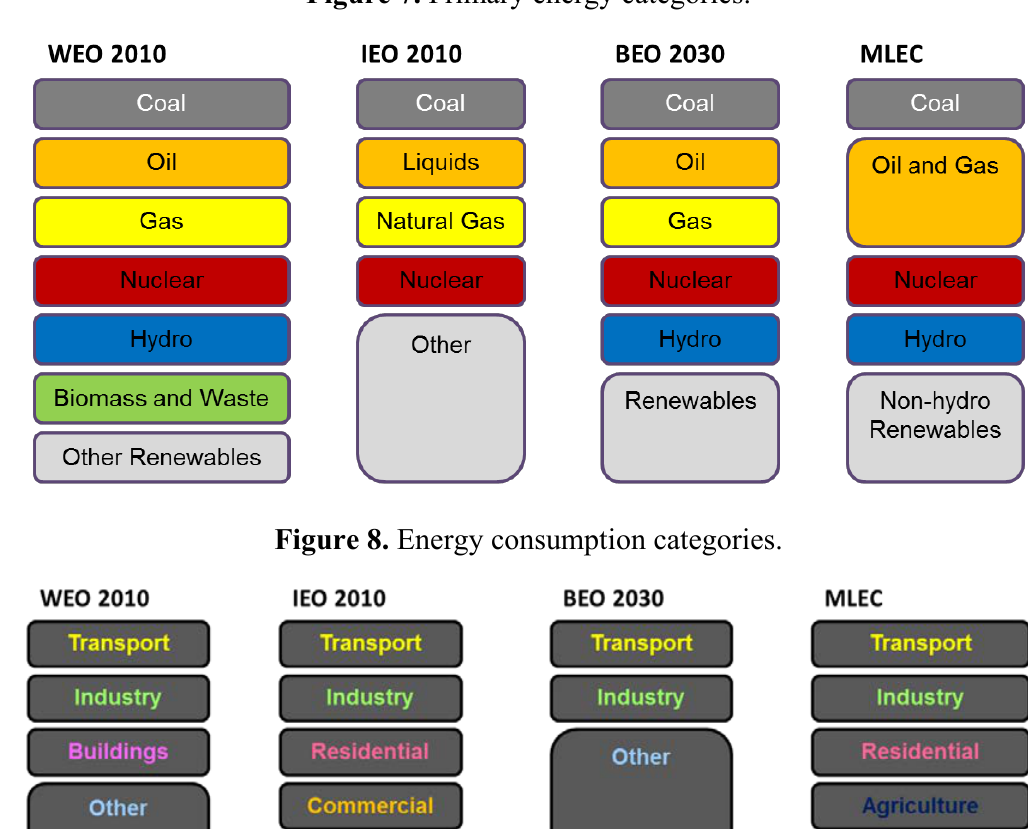
Figure 7. Primary energy categories.